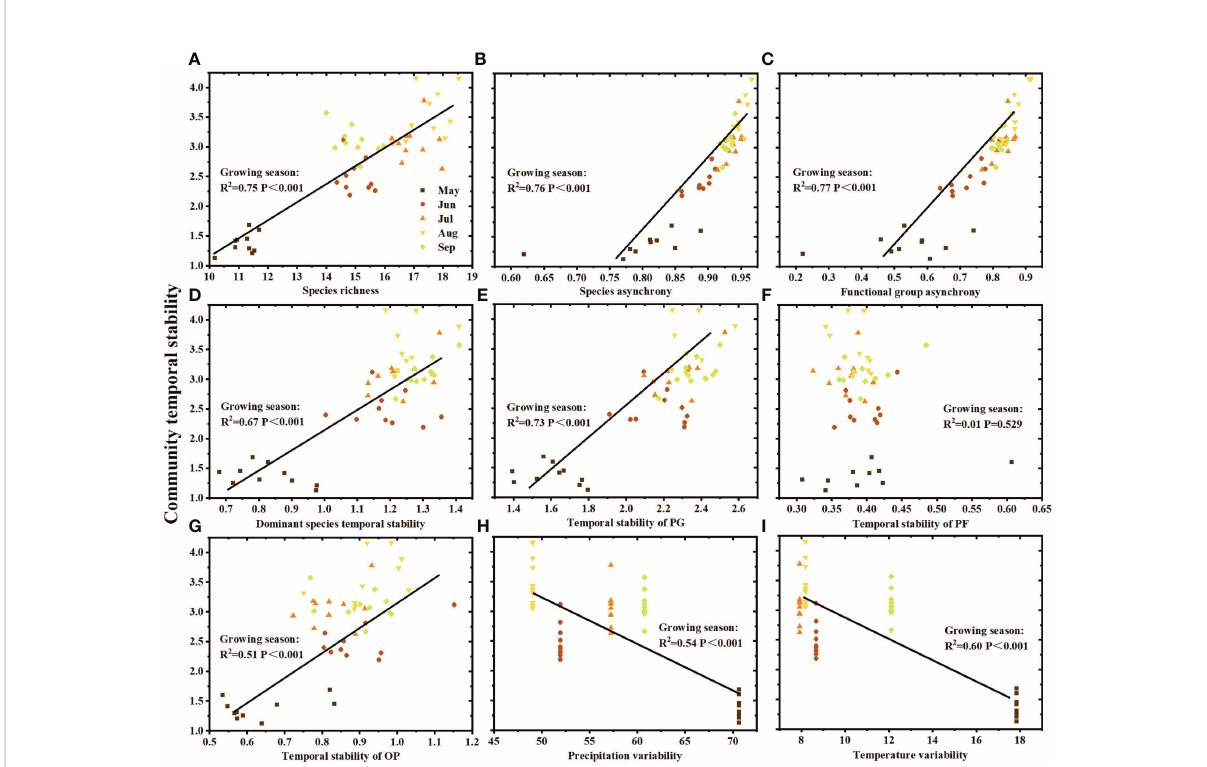
FIGURE 4 Community temporal stability in relation to (A) species richness, (B) species asynchrony, (C) functional group asynchrony, (D) dominant species temporal stability, (E) temporal stability of PG (perennial grass), (F) temporal stability of PF (perennial forbs), (G) temporal stability of OP (other plants), (H) precipitation variability and (I) temperature variability. Different colors represent the months from May to September (n = 10 each